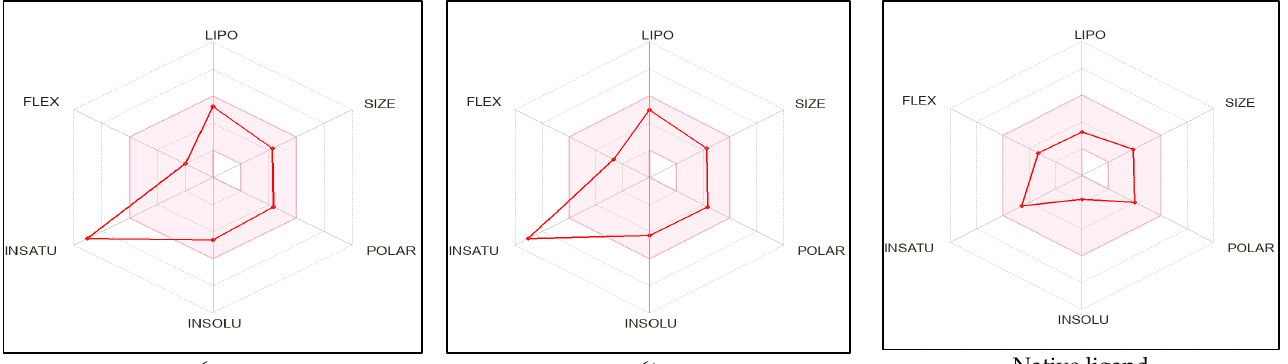
6s 6t Native ligand